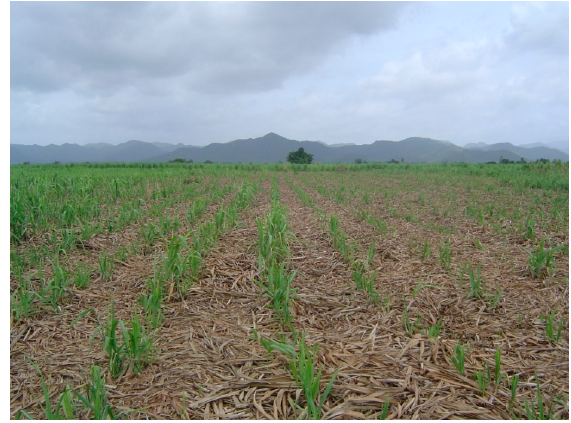
Figure 6. Sugarcane field after harvesting by hand.